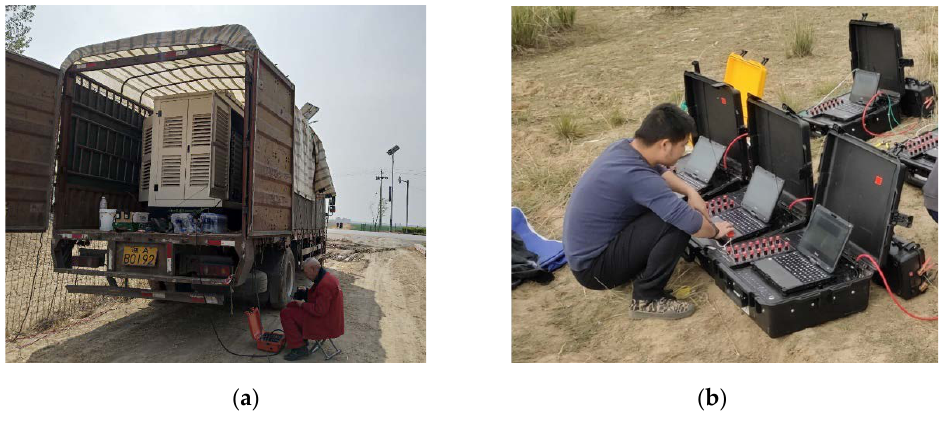
Figure 3. ( a ) WFEM transmitter and ( b ) is the receiver.